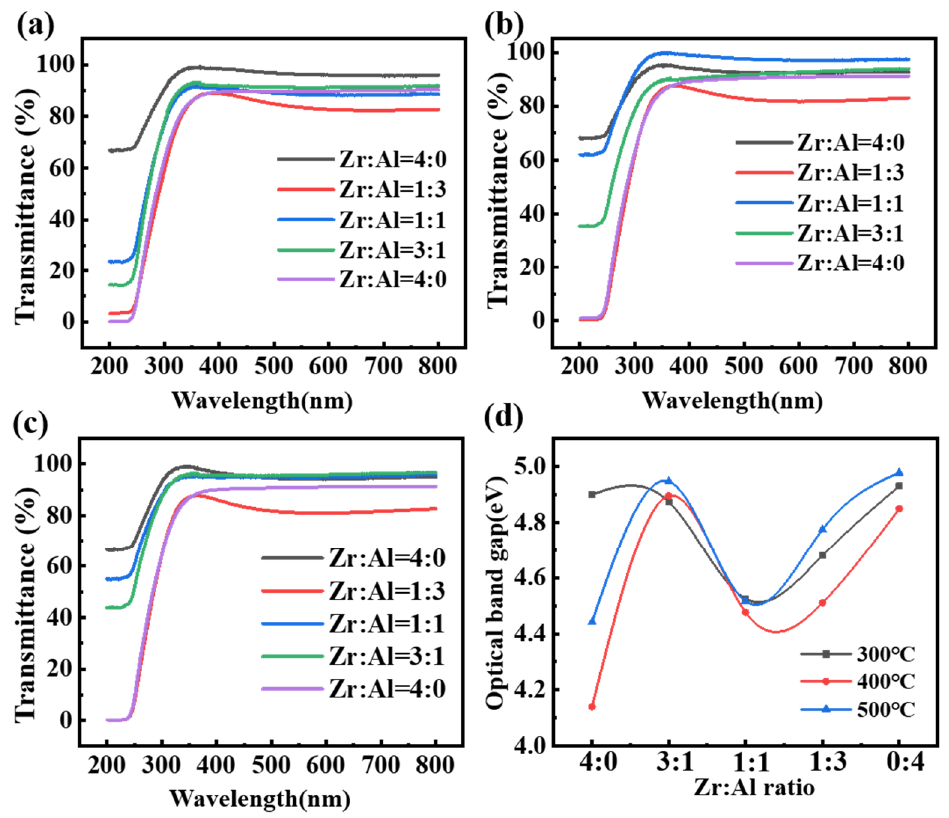
Figure 4. Transmittance of the ZAO films of different ratios annealed at: ( a ) 300 °C; ( b ) 400 °C; and ( c ) 500 °C, respectively; and ( d ) optical bandgaps of the ZAO films changing with the mixing ratio of zirconia and alumina annealed at various temperatures.